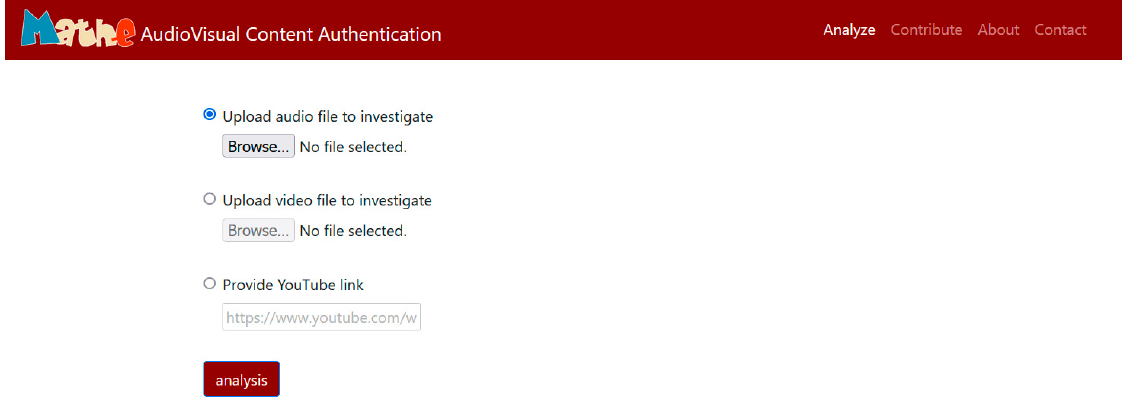
Figure 2. The interface where users can provide audio/video files for analysis.